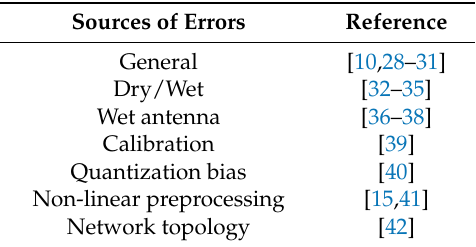
Table 3. Errors and uncertainties